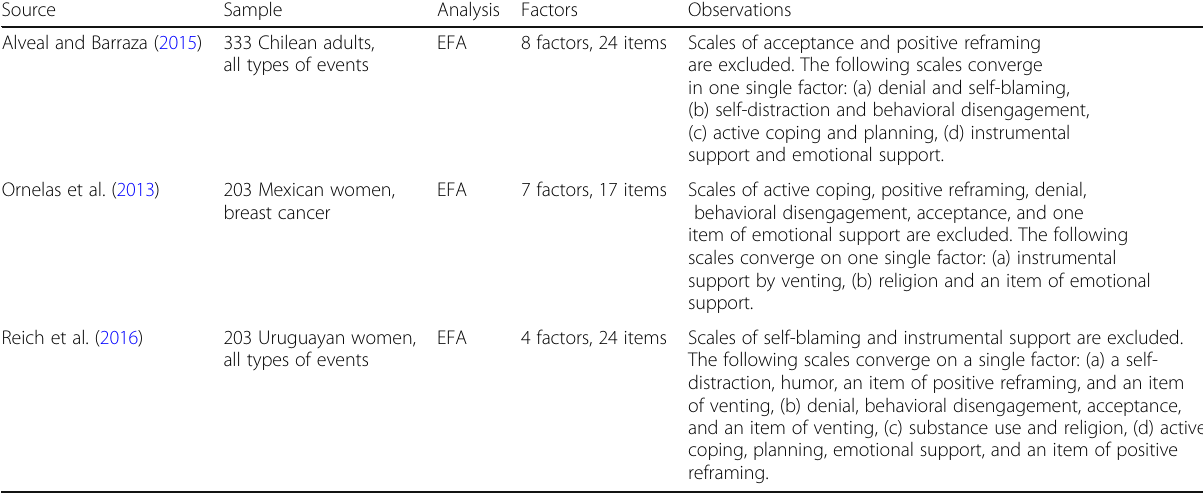
Source Sample Analysis Factors